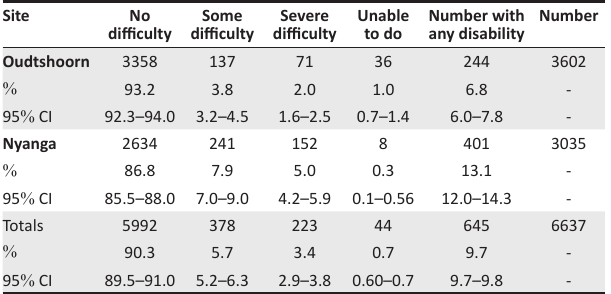
TABLE 5: Prevalence of disability in the two sites (Oudtshoorn N = 4028, Nyanga N = 3308).